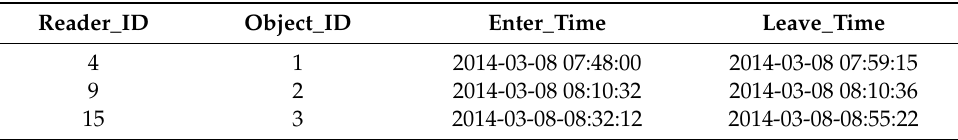
Table 1. An example of indoor tracking